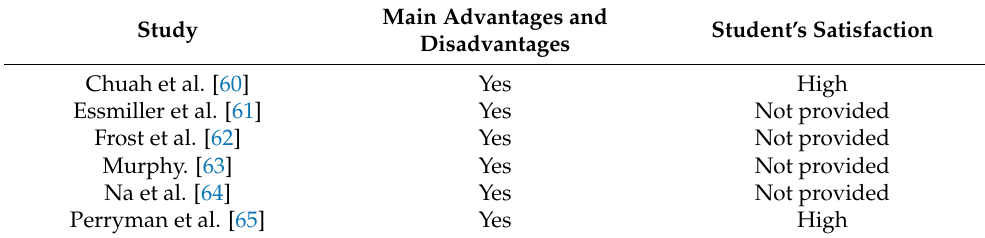
Table 4. Secondary outcomes (n =